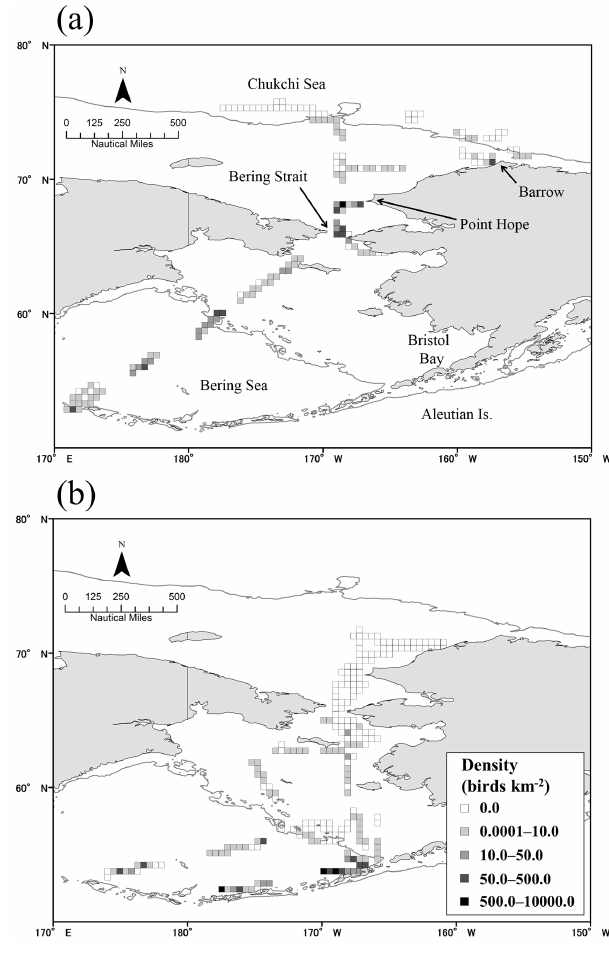
Figure 1. Study area and densities (birdskm − 2 in each 50km 2 grid) of short-tailed shearwaters ( Ardenna tenuirostris ) in fall 2012 (a) and summer 2013 (b) . Solid gray lines indicate the 200m depth